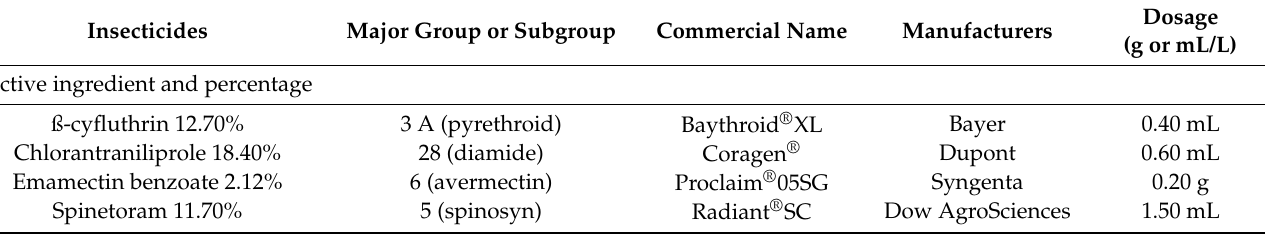
Table 1. Active ingredients and their percentages, insecticide group, commercial names, manufactur- ers and dosages of four insecticides used in field applications and bioassays to control corn earworm ( Helicoverpa zea (Boddie) (Lepidoptera: Noctuidae)) and fall armyworm ( Spodoptera frugiperda (J. E. Smith) (Lepidoptera: Noctuidae)) larvae in 2019 through